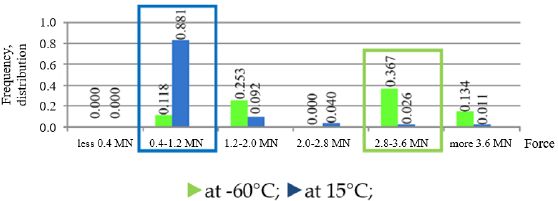
Figure 1. Distribution of the longitudinal forces that transfer through the bumpers.